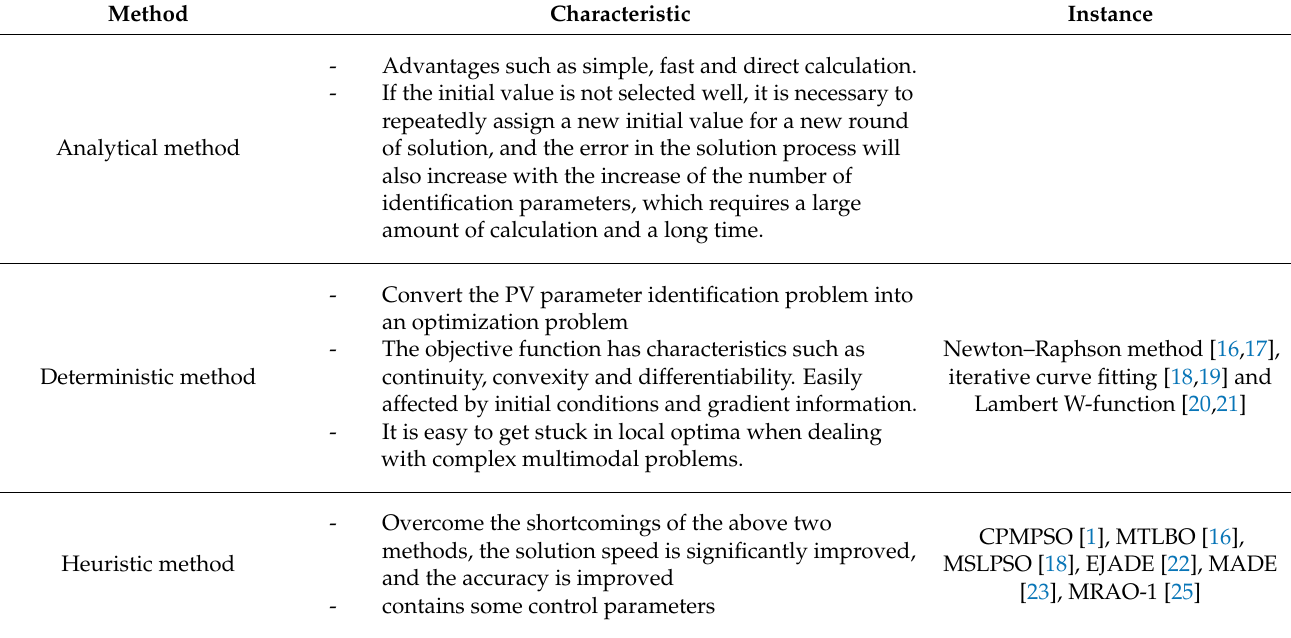
Table 1. The characteristics of the three